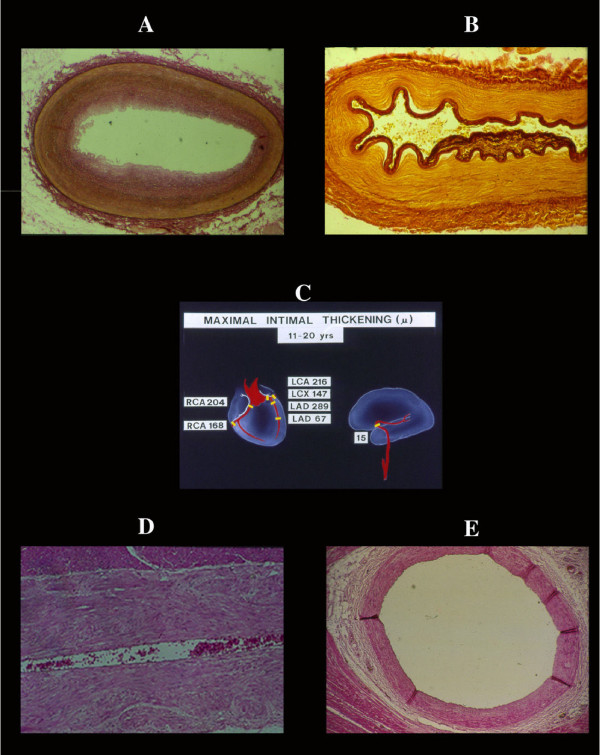
Comparison between the intimal thickening of the LAD (A) and the middle cerebral artery (B) of the same 18-year old subject. In the latter artery the intimal thickening is minimal in contrast to that of LAD which is circumferential with a thickness greater than tunica media. C), difference in maximal thickness in microns found in main coronary arteries and branches in respect of the middle cerebral artery. D), absence of intimal thickening in the LAD of dogs, despite and identical morpho-function. This suggests a possible role of the neurogenic control of coronary arteries in humans. On the other hand the absence of intimal thickening in the "mural tract" of coronary arterial vessels (E) emphasizes the role of systolic dynamic stresses on arterial wall free to expande versus those protected by encircling contracted myocardium.